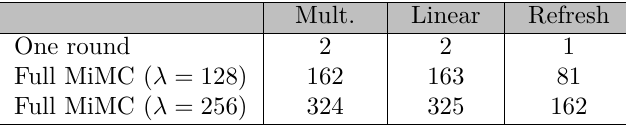
Table 5: Gadget counts for masked MiMC. Mult.